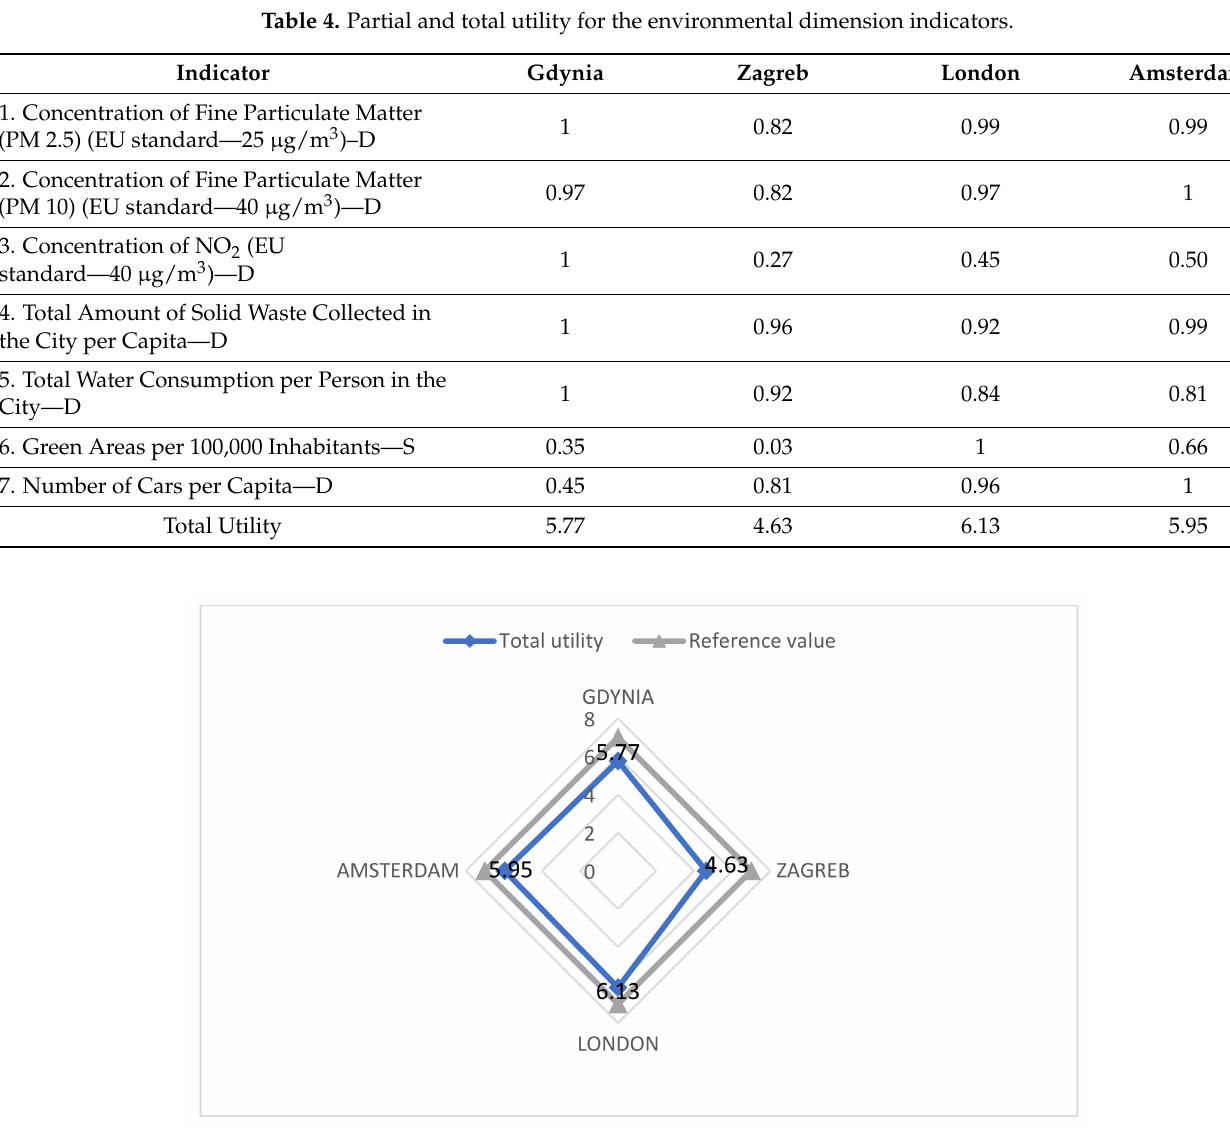
Figure 2. Total utility for the environmental dimension indicators in selected European